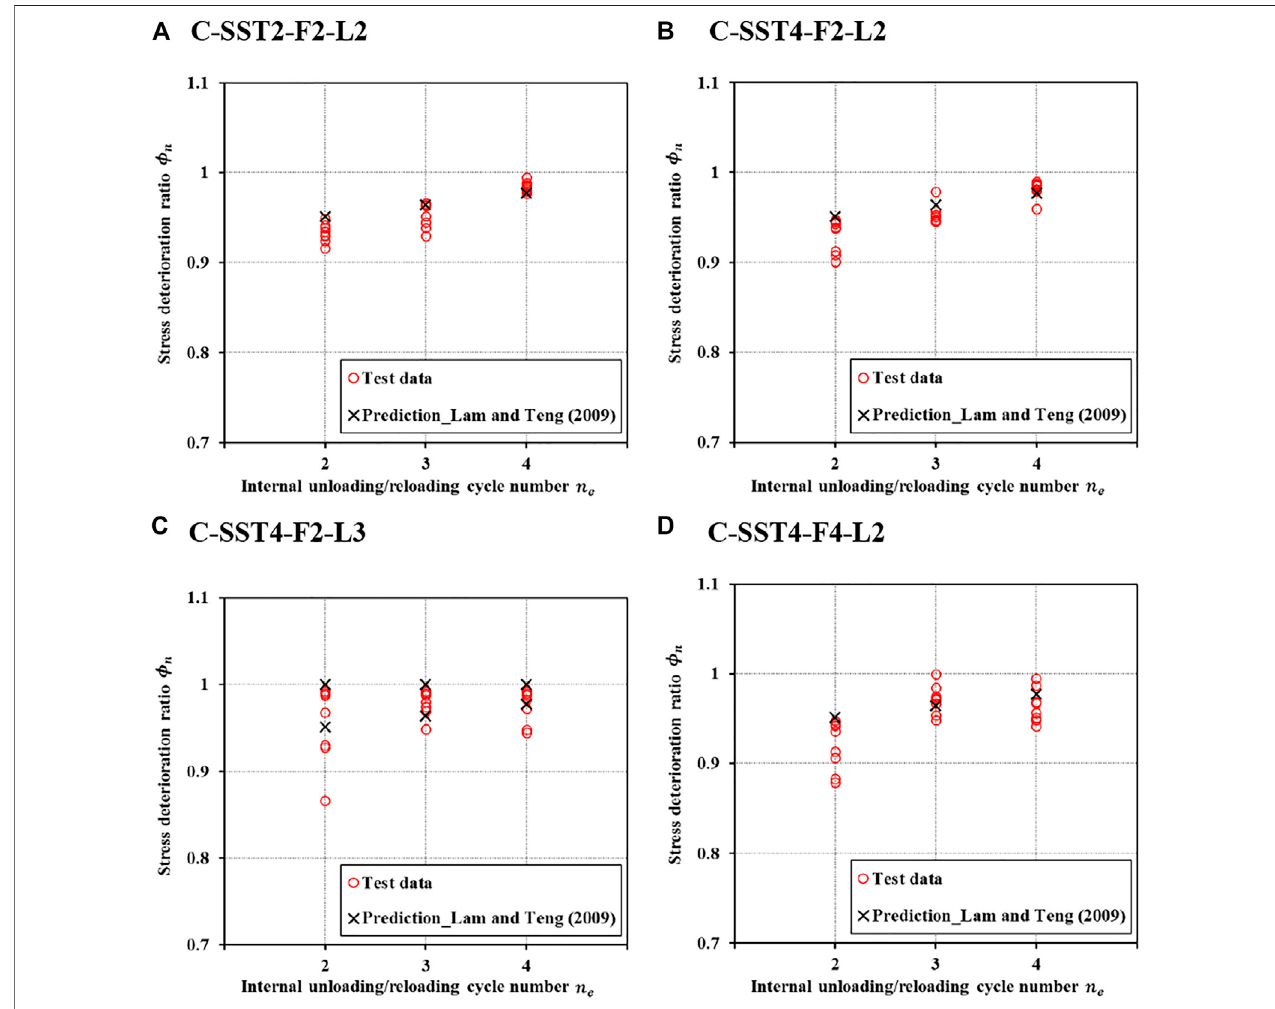
FIGURE 13 | Comparisons of stress deterioration ratios of internal cycles ϕ n . (A) C-SST2-F2-L2. (B) C-SST4-F2-L2. (C) C-SST4-F2-L3. (D) C-SST4-F4-L2.